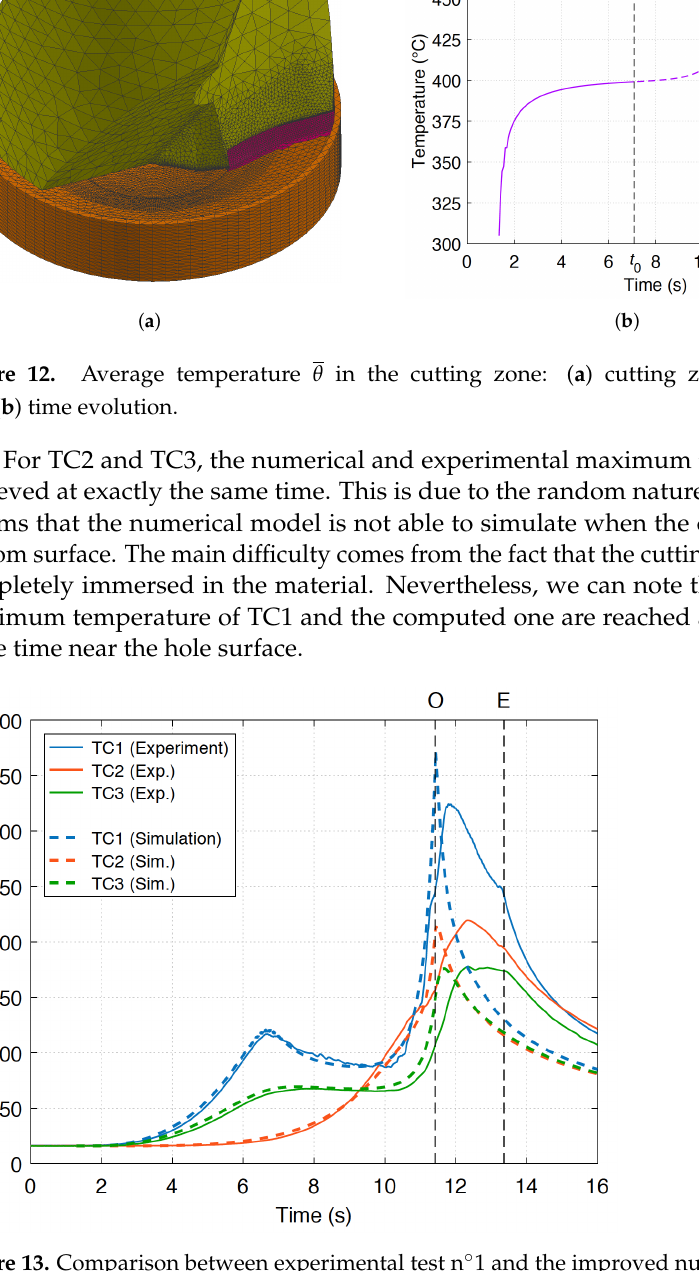
Figure 13. Comparison between experimental test n ◦ 1 and the improved numerical